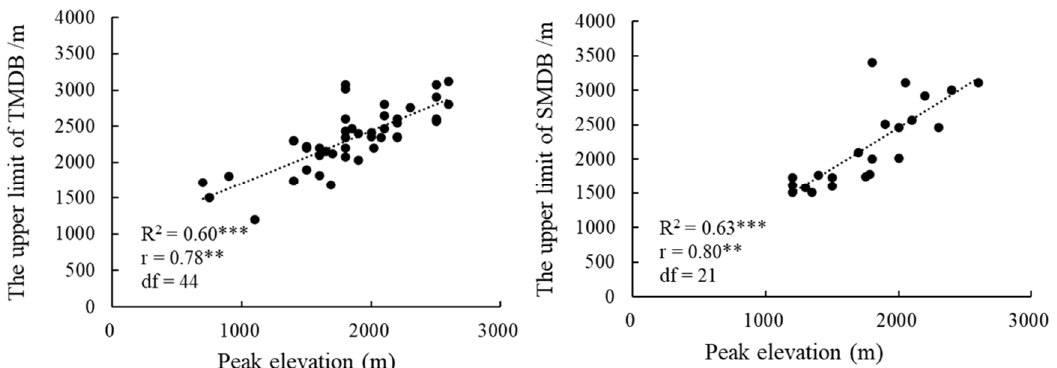
Figure 6. The effect of peak elevation on the upper limit of deciduous broad-leaved forest. TMDB, deciduous broad-leaved forests on the temperate mountains without climatic treeline; SMDB, deciduous broad-leaved forest on the subtropical mountains without climatic treeline. “r value” represents Pearson correlation coefficient. df, degree of freedom. Note: ** p <0.01, *** p < 0.001.